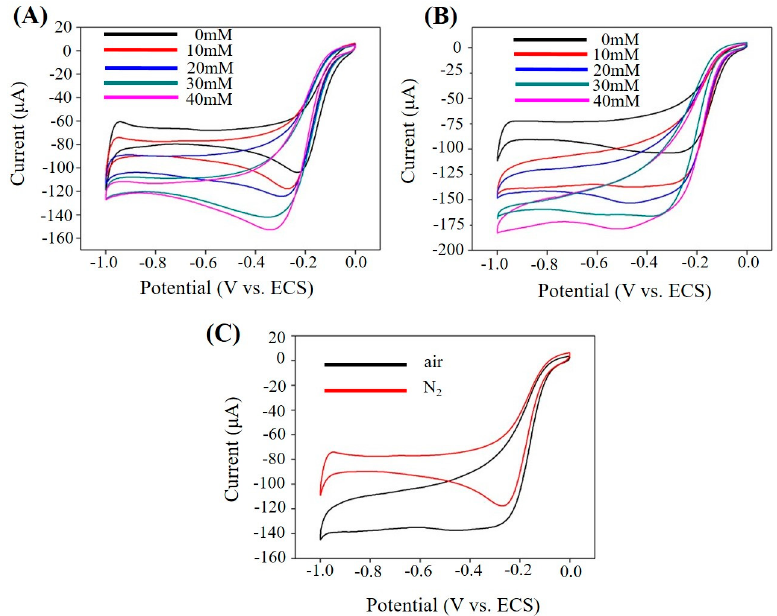
Figure 6. PAN–PtNPs/GCE for sensing test (scan rate: 50 mV/s, PBS, PH = 7.4): ( A ) Typical CV curves of PAN–PtNPs/GCE with different H 2 O 2 concentrations under N 2 atmosphere; ( B ) Typical CV curves of PAN–PtNPs/GCE with different H 2 O 2 concentrations under air atmosphere; ( C ) Corresponding CV curves with the same H 2 O 2 concentration under air and N 2 atmosphere.